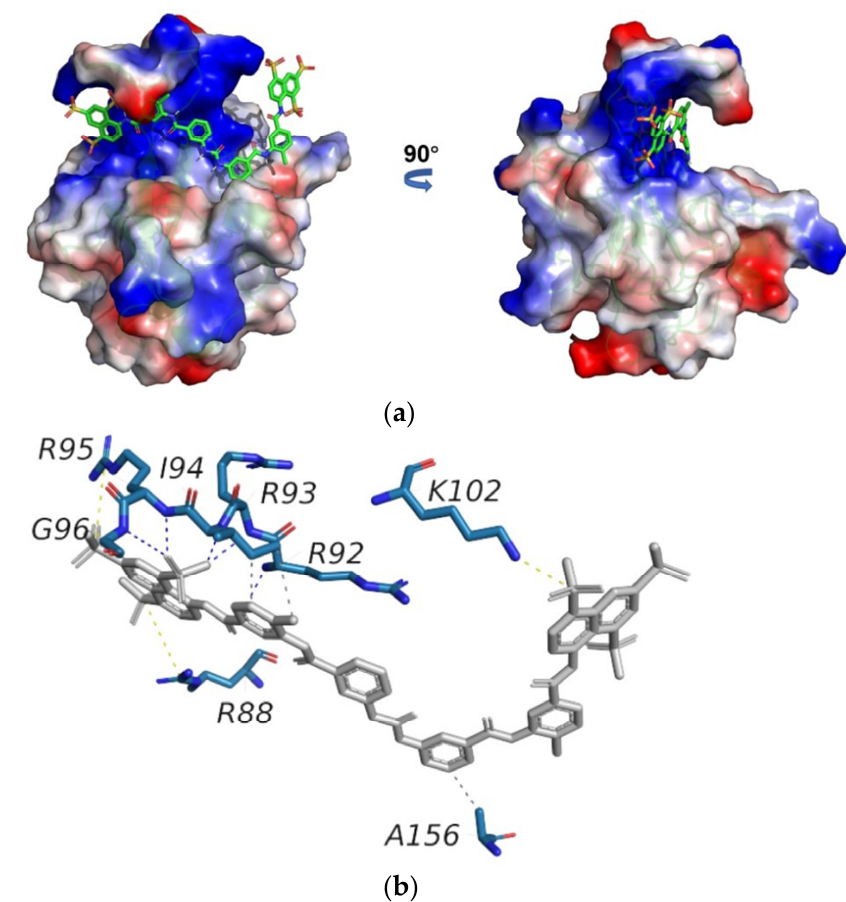
Figure 5. Structural model of the SARS-CoV-2 N-NTD-suramin complex. ( a ) The docking model was built using HADDOCK. Suramin is shown in grey. ( b ) Schematic diagram of intermolecular interactions in the structural model of N-NTD-suramin produced using PLIP 2.2.0 online software.